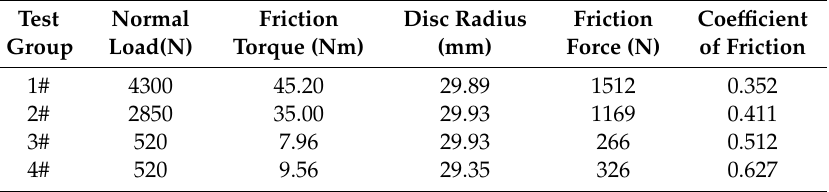
Figure 4. The evolution of real-time friction torques during four sets of tests. Table 4. The friction-related parameters at 50 k rolling cycles for four sets of